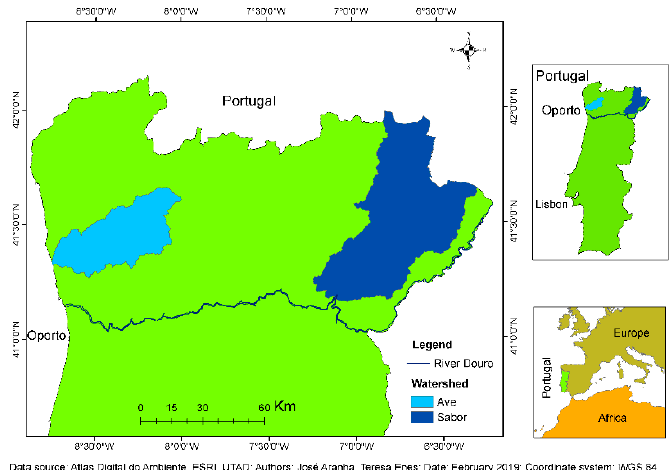
Figure 1. Portugal world geographical location. Sampling areas.